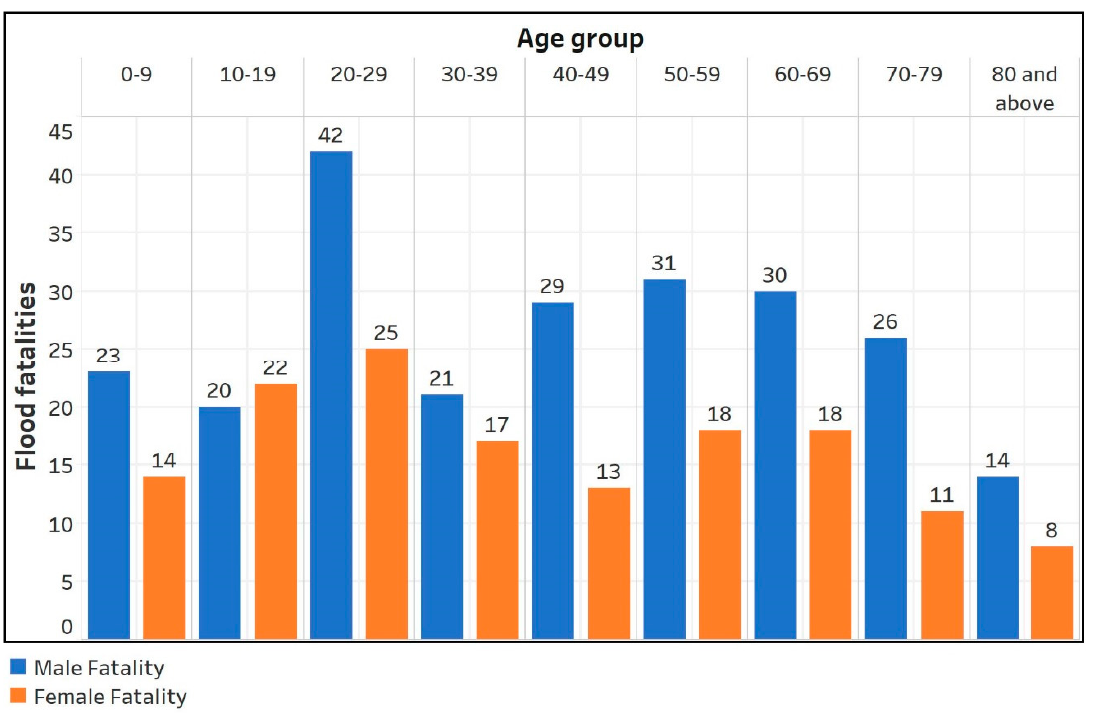
Figure 7. Proportions of vehicle-related flood fatalities by gender.